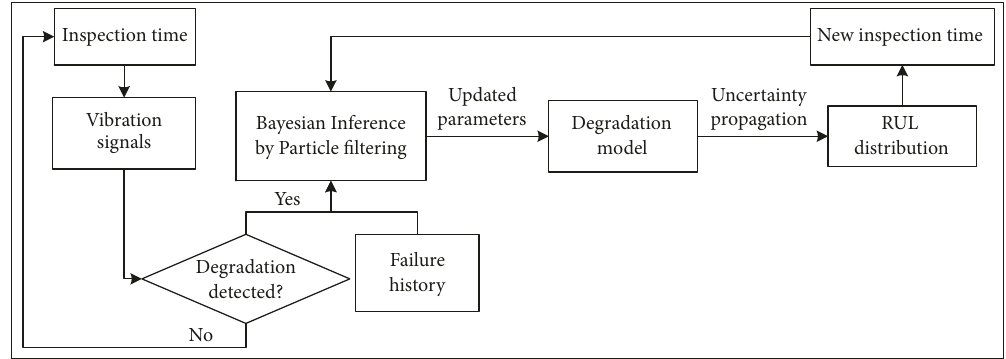
Figure 1: Flowchart of the proposed method.